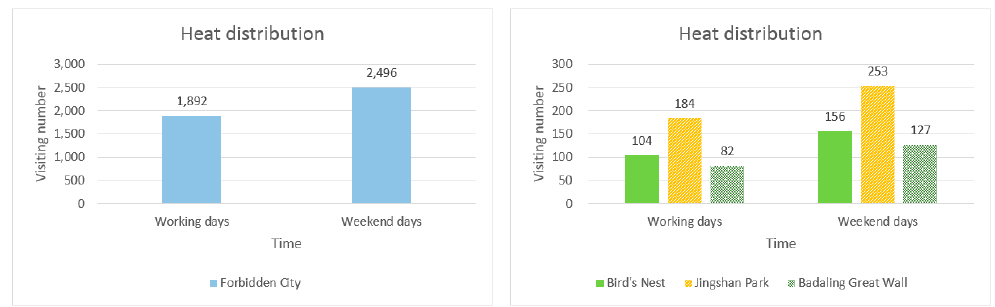
Figure 16. Heat distribution map divided by slack/busy seasons.